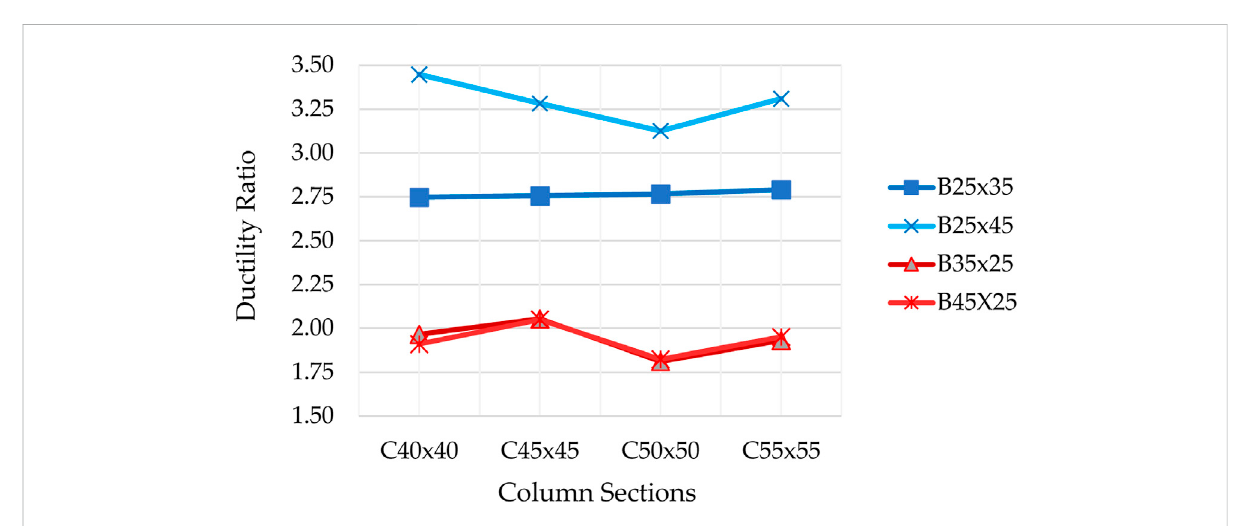
FIGURE 8 Global ductility ratio